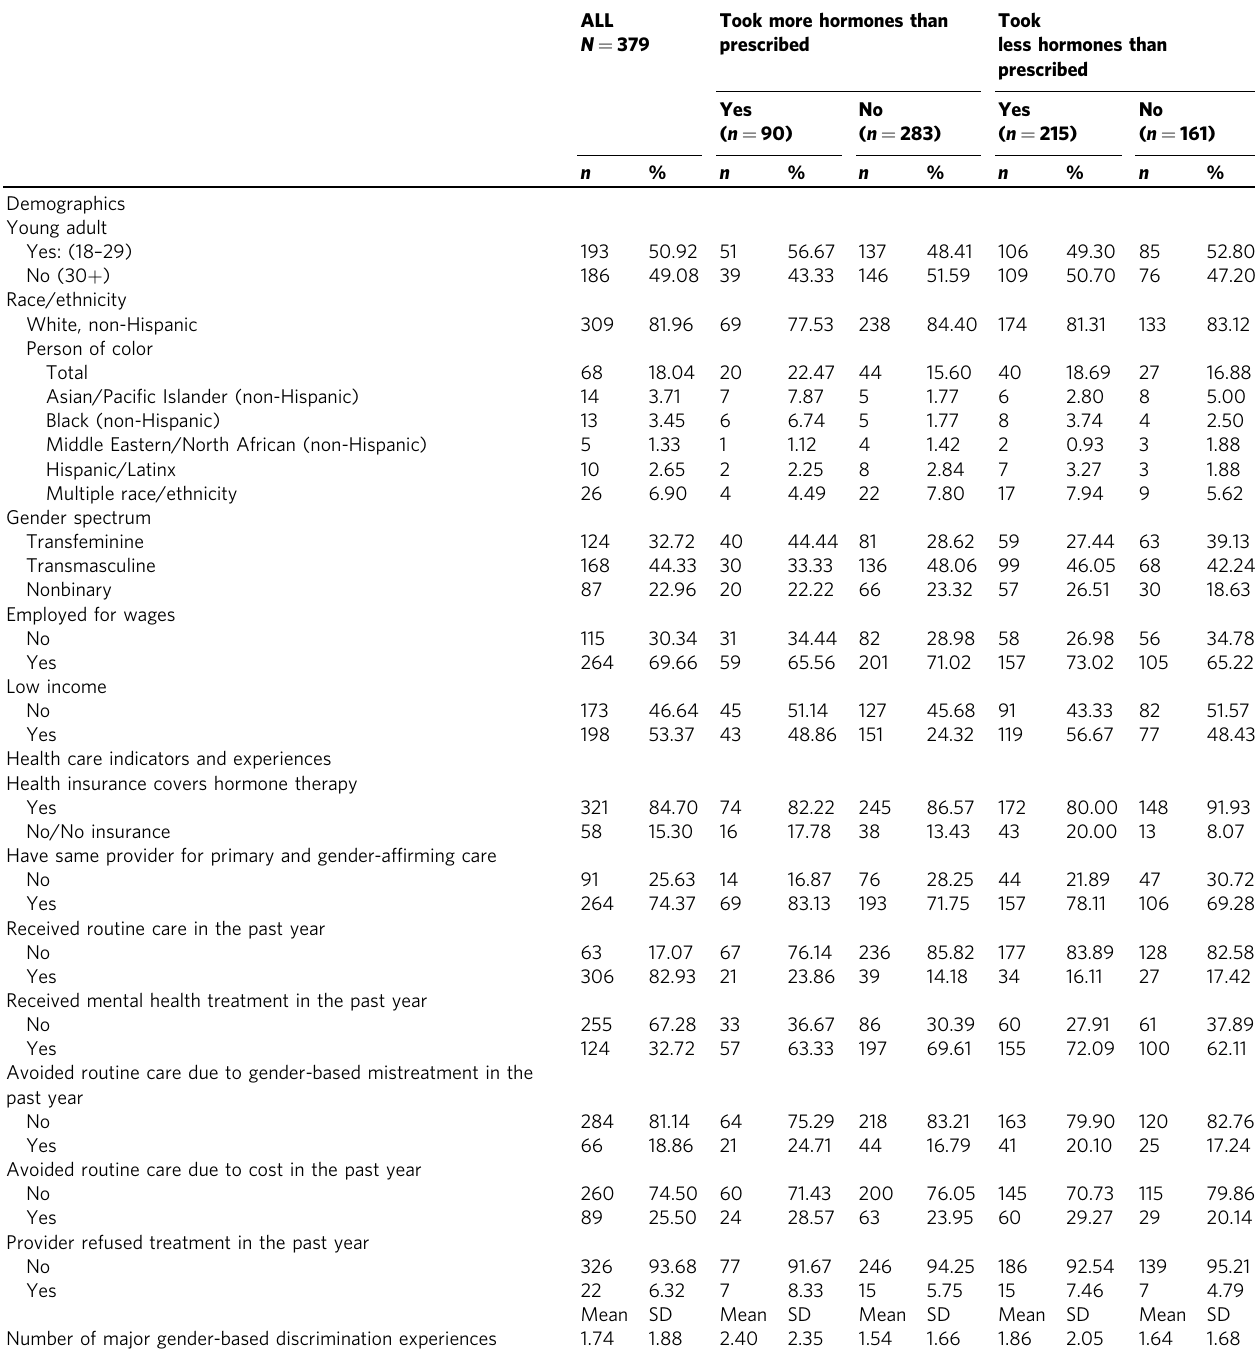
Table 1 Sample characteristics of transgender adults reporting hormone use in Massachusetts and Rhode Island ( n =